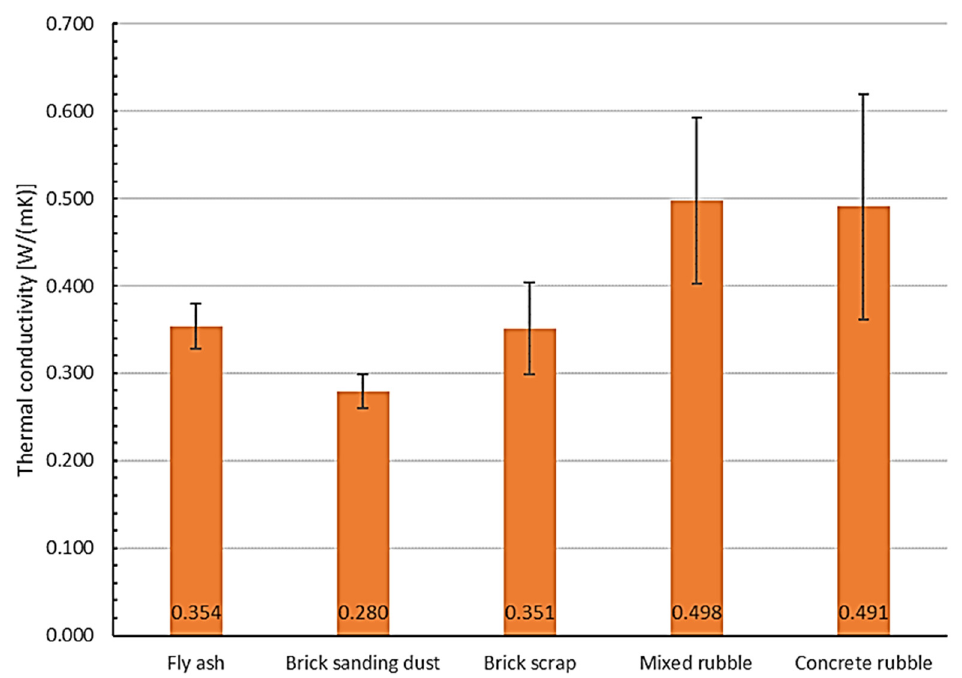
Figure 9. Mean values of thermal conductivity of geopolymer bricks produced from residual materials with associated standard deviations.